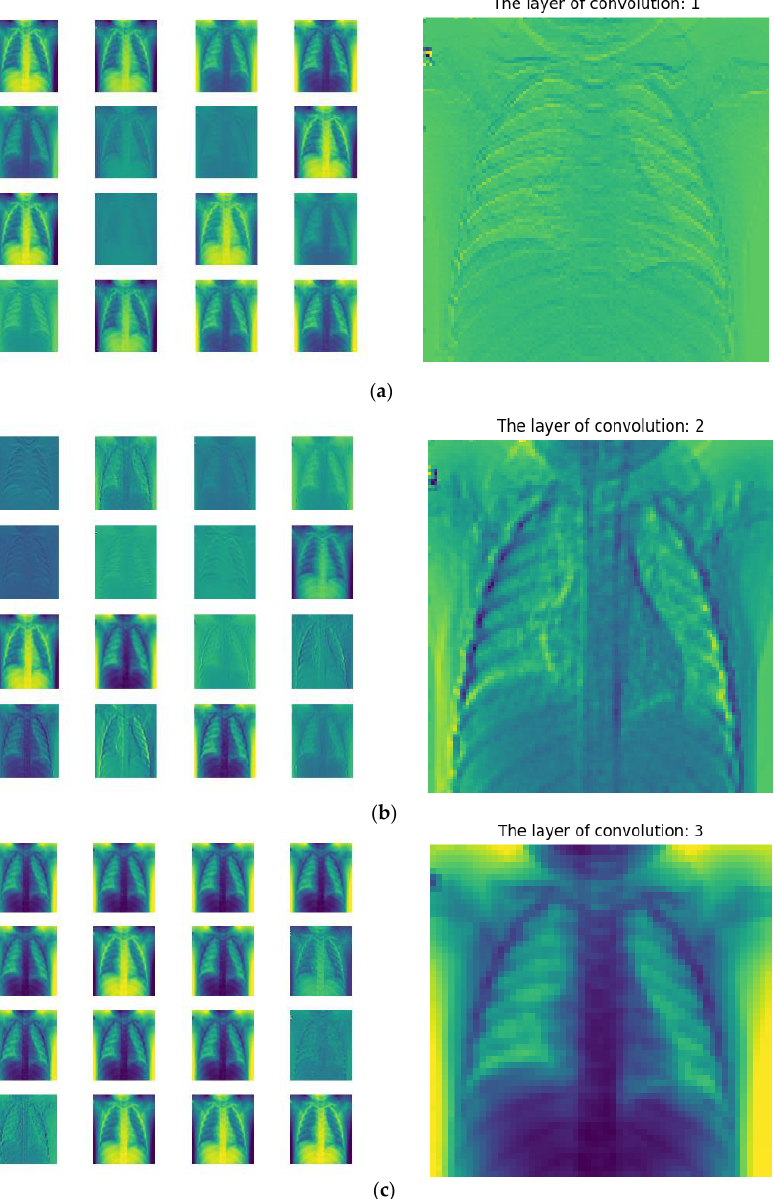
Figure 11. ( a – c ) shows the first 16 channel maps of the features extracted by the first three convolu- tional layers of base classifier 1 and their overlay fusion on the right, some feature maps are